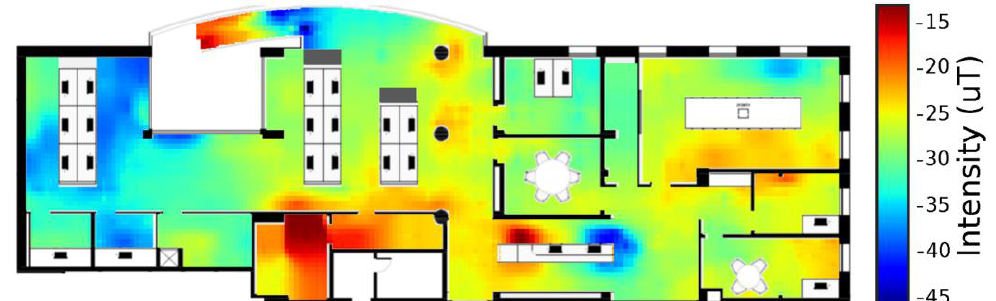
Figure 3. Plan of a building used to test an algorithm for the construction of the magnetic fingerprint. The vertical bar on the right represents the magnetic field intensity. In the floor plan, colour intensity correlates with people activity. Data were collected from six people walking with their smartphones and the walking paths were then acquired (reproduced under the terms and conditions of the Creative Commons Attribution (CC BY) license from [70]).